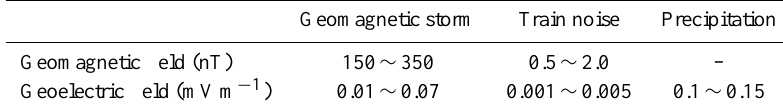
Table 1. ULF electromagnetic changes associated with some sources.